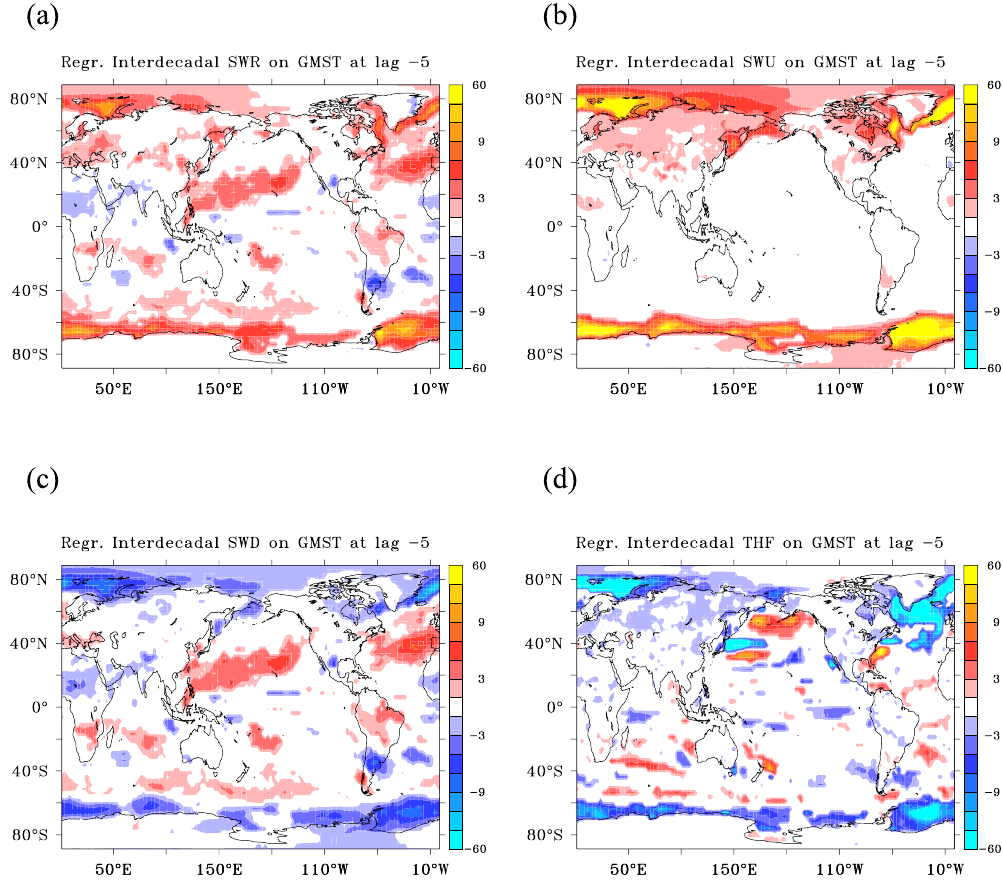
Figure 3. The SWR and THF patterns preceding a decadal GMST anomaly. ( a – d ) Regression patterns at lag − 5, leading GMST by 5 years. Net shortwave radiation leading GMST by 5 years ( a ); same for upwelling shortwave radiation ( b ); downwelling shortwave radiation ( c ); Turbulent fluxes ( d ). All regression patterns are in (W m − 2 K − 1 ). In ( a , d ) colour intervals are 2 W m − 2 K − 1 , but the first and last intervals are − 60 to − 13 and 13 to 60 W m − 2 K − 1 . Only significant values using 95% confidence intervals are shown. This figure has been created with the free Ferret software package developed by the National Oceanic and Atmospheric Administration (NOAA) and available from